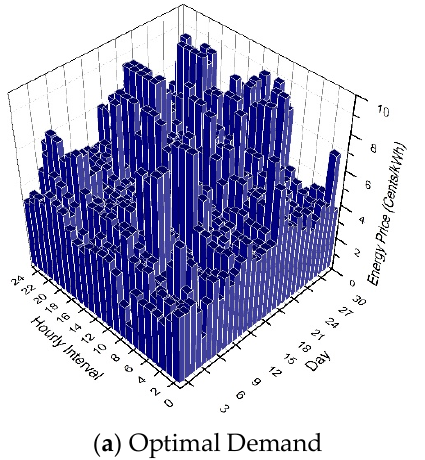
Figure 8. Utility monthly price variations.